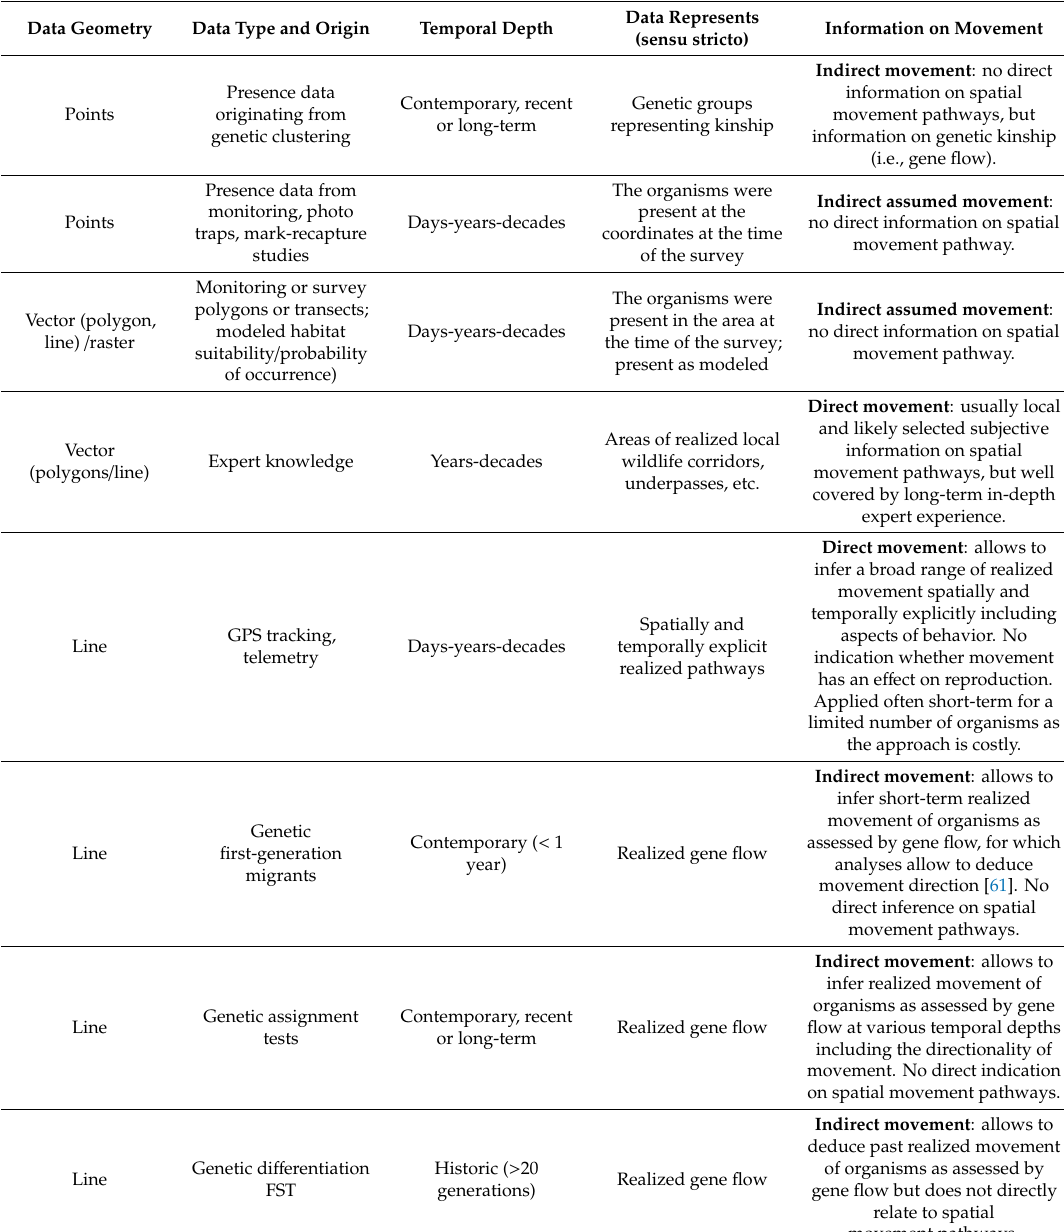
Table 1. Types of descriptor data for movement used in connectivity